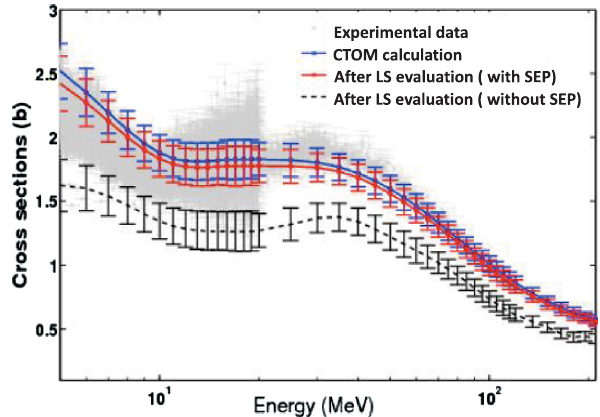
Fig. 6. The Gaussian analysis to the counts of ratio in 20 – 200 MeV.